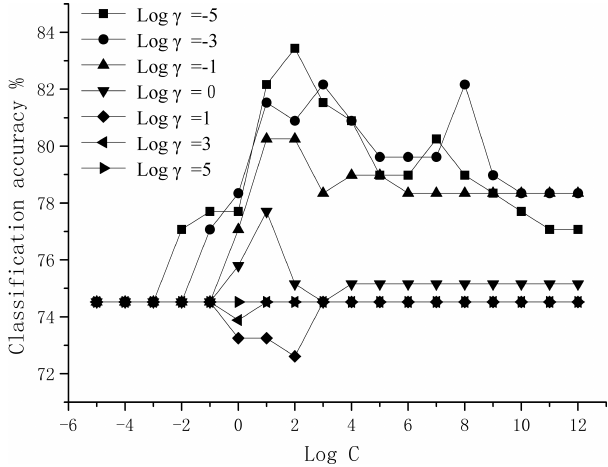
Fig. 4. Dependence of classi¯cation accuracy on parameters C and (cid:1) for a RBF SVM. The base of log C is 2 and the base of log (cid:1) is 2.